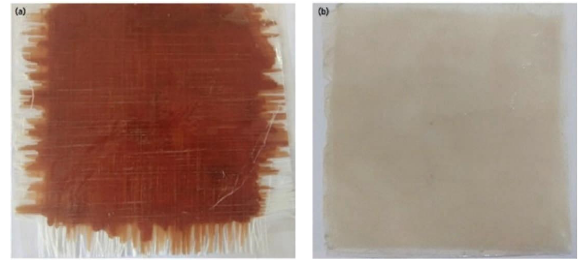
Figure 3: Composite samples prepared of double layers oriented in biaxial direction: (a) silk fbres and (b) silk